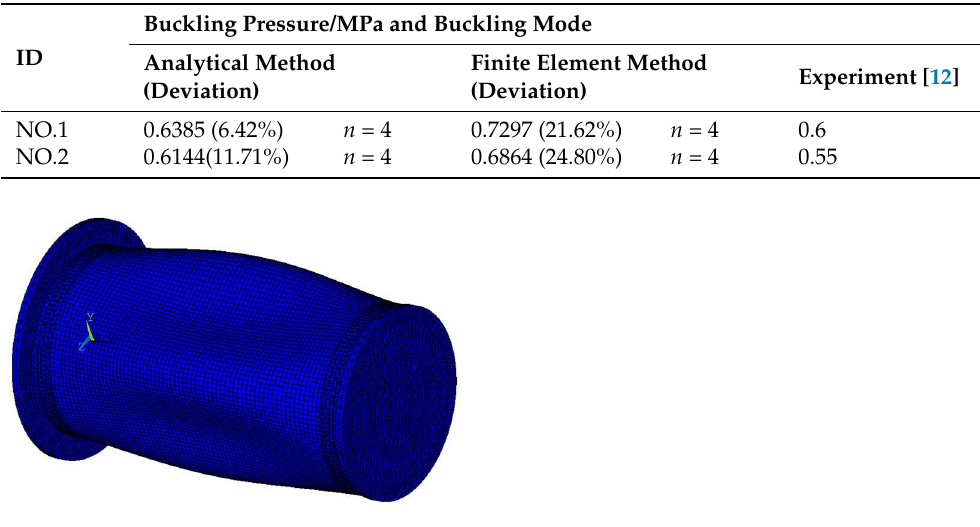
Table 5. Comparison of the critical buckling pressures.